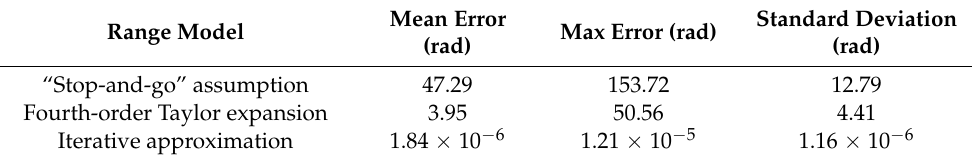
Figure 5. Fitting error comparison of several GEO SAR range models. ( a ) “Stop-and-go” assumption; ( b ) fourth-order Taylor expansion; and ( c ) iterative approximation. Table 2. Fitting error comparison of several GEO SAR range models.